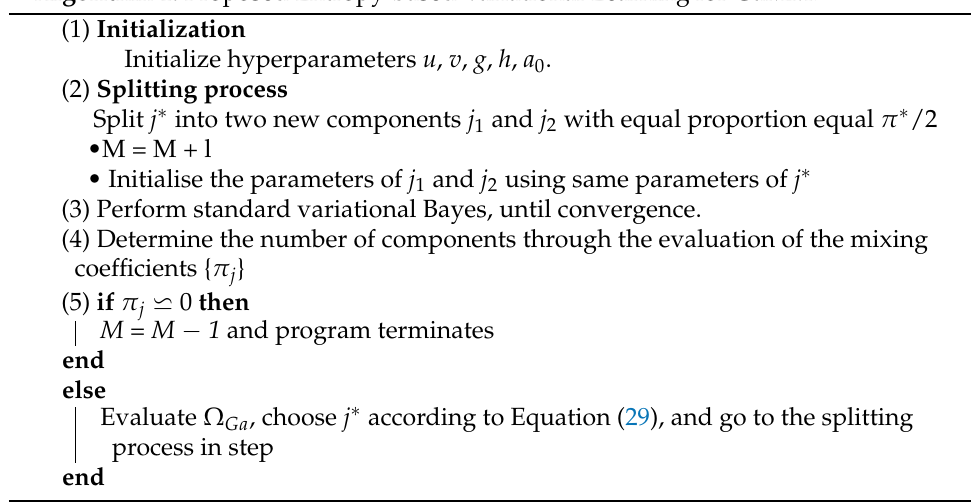
Algorithm 1: Proposed Entropy-based Variational Learning for